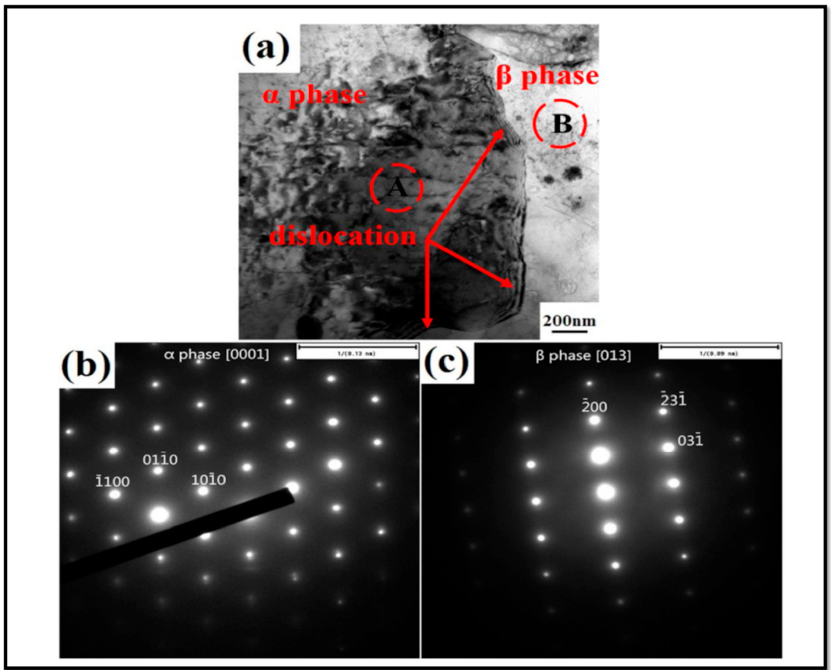
Figure 13. TEM image and SAED patterns at SZ of the friction stir processed LZ91 alloy: ( a ) bright field image, ( b ) SAED pattern of A zone, and ( c ) SAED pattern of B zone (Reprinted with permission from ref. [24]. Copyright 2018 Elsevier B.V.).